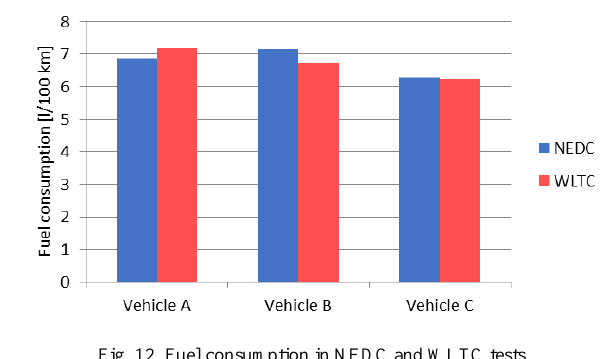
Fig. 12. Fuel consumption in NEDC and WLTC tests